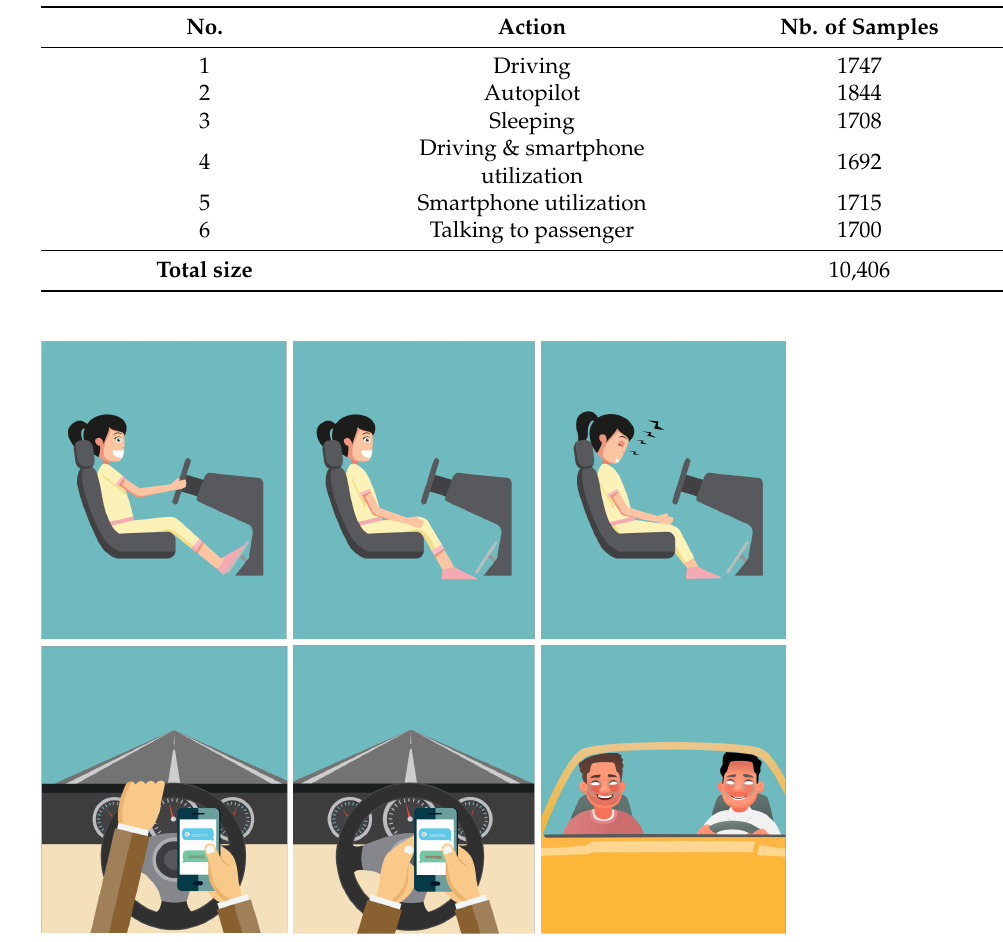
Figure 3. Overview of six driving activities recorded with UWB radar Xethru X4M02. Top ( left to right ): Driving, Autopilot, Sleeping. Bottom ( left to right ): Driving and Smartphone Utilization, Smartphone Utilization, Talking to Passenger. Credits: Adobe